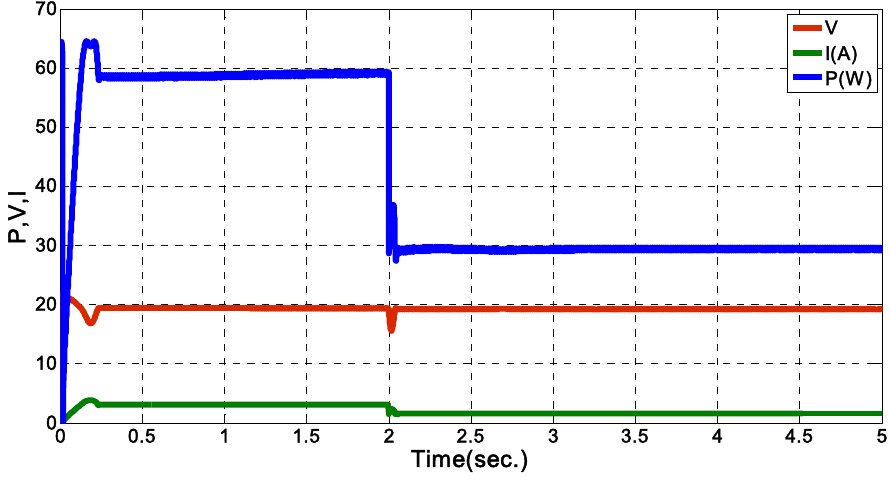
Figure 13. Time response of a conventional ESC system in the context of an abrupt irradiance change from 1 kW/m 2 to 600 W/m 2 at Time = 2